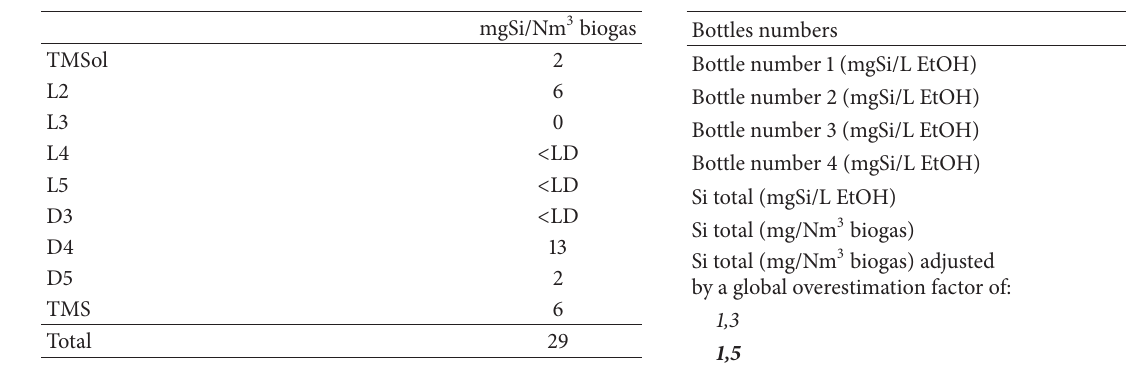
Table 3: GC-MS analysis (LFG B3). Table 4: ICP-OES analysis (LFG B3).